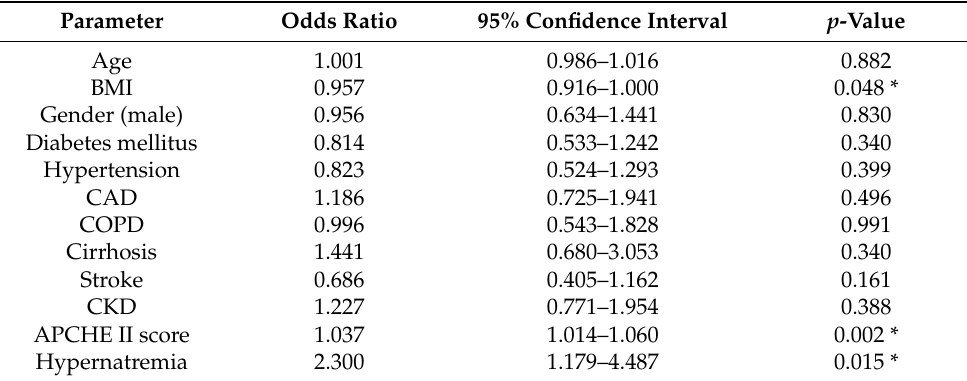
Table 3. Multivariate binary regression analysis for hospital mortality risk factors.